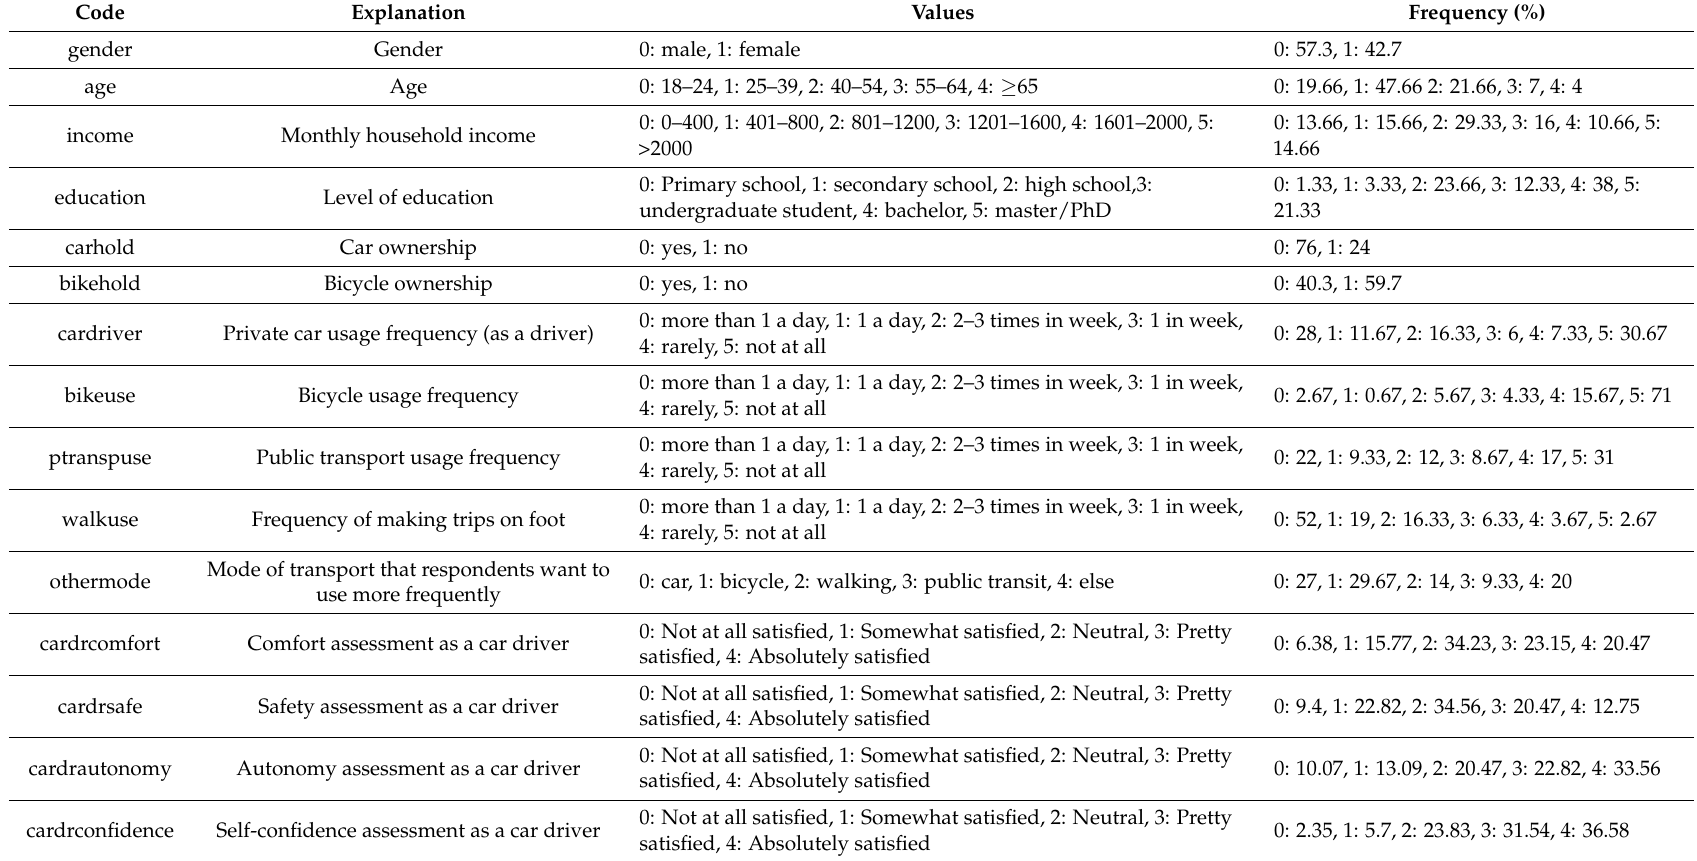
Table A1. Coding and descriptive statistics of the variables used in the